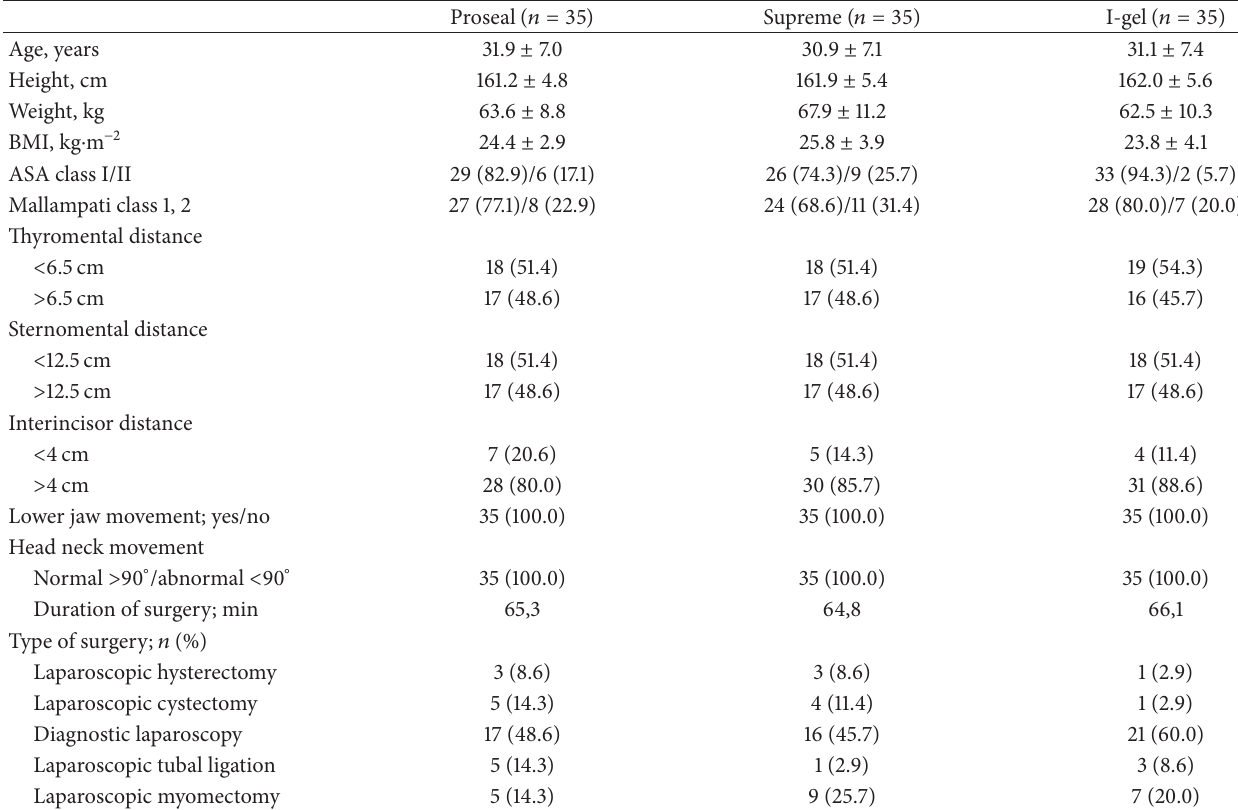
Table 1: Patients airway and surgery